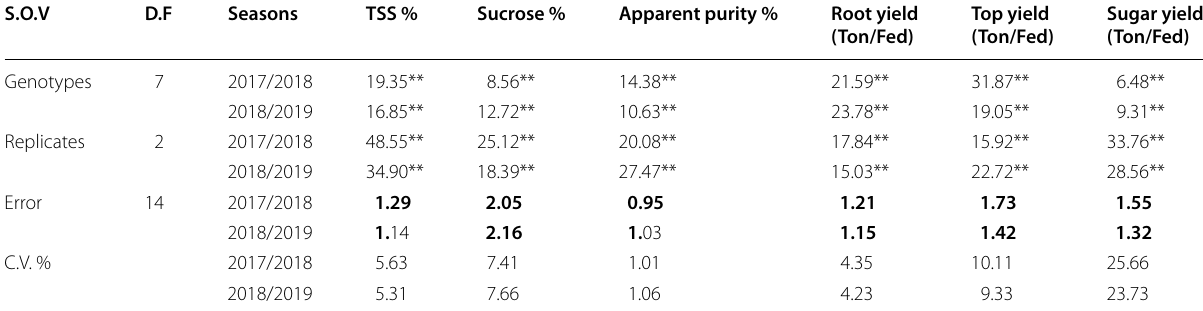
Bold values are very important values that are used in the case of important comparisons in the results and discussion parts